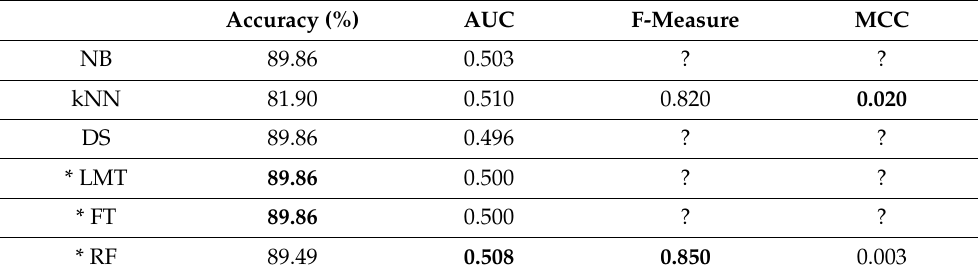
Table 4. The CCP performance of DF models and ML classifiers on Dataset